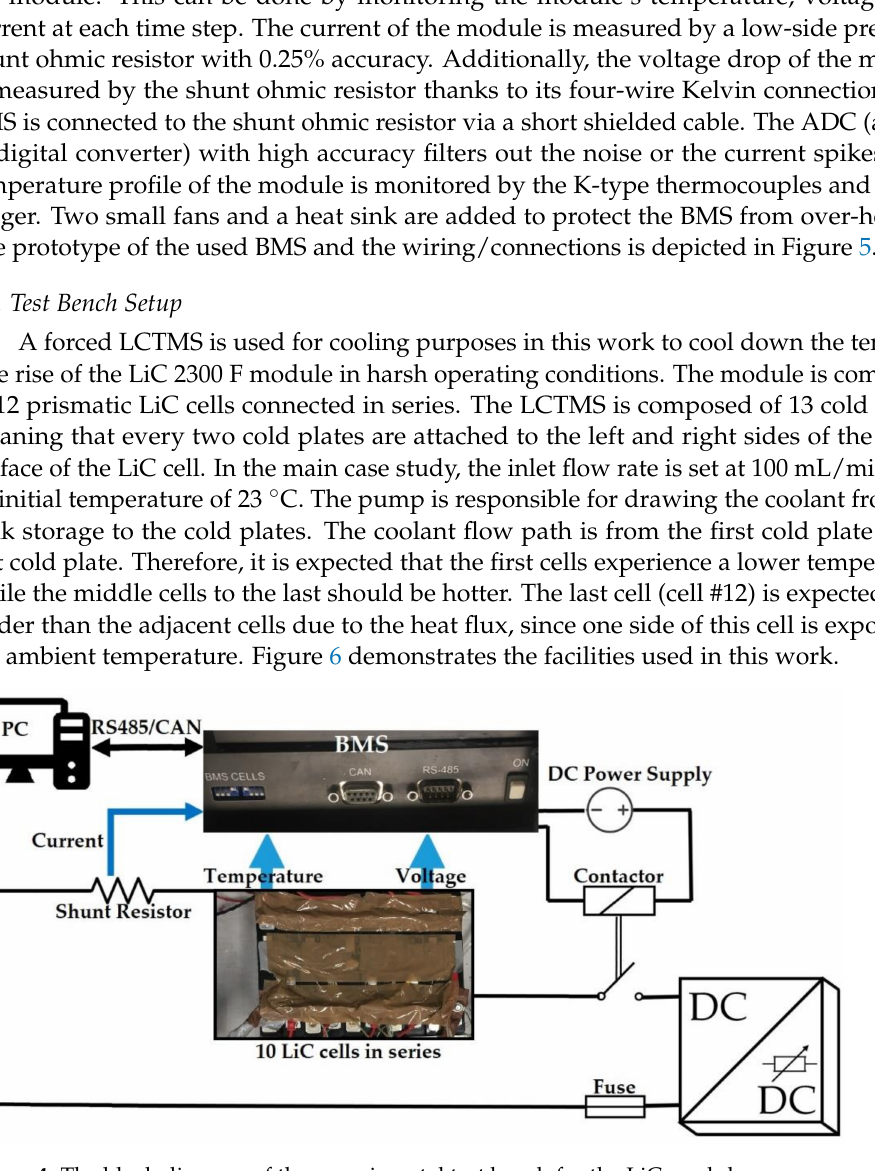
Figure 4. The block diagram of the experimental test bench for the LiC